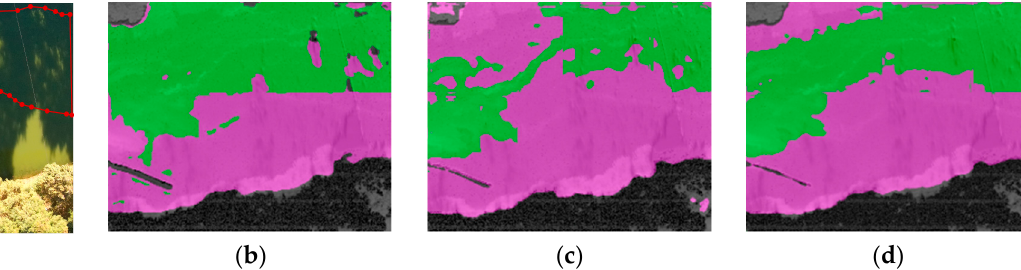
Figure 8. Detection results of different deep-learning algorithms for reflection scene: ( a ) visible light images; ( b ) detection results of FCN; ( c ) detection results of SegNet; ( d ) detection results of improved transformer model.